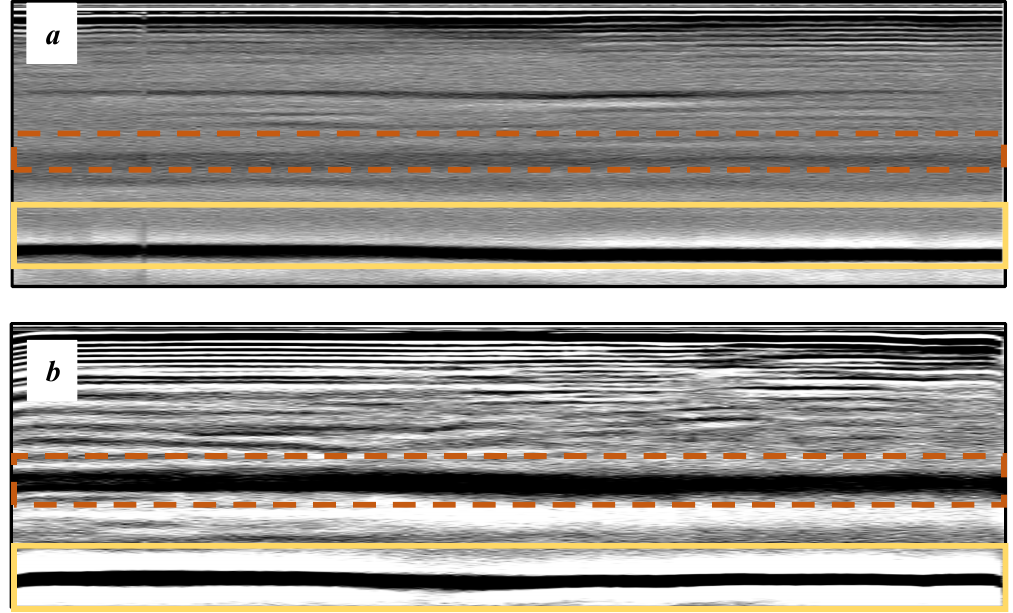
Figure 8. The internal structure of samples; ( a ) Pleated connection, PLA Though ™ , and ABS; ( b ) Overlap connection, PLA Though ™ , and ABS.